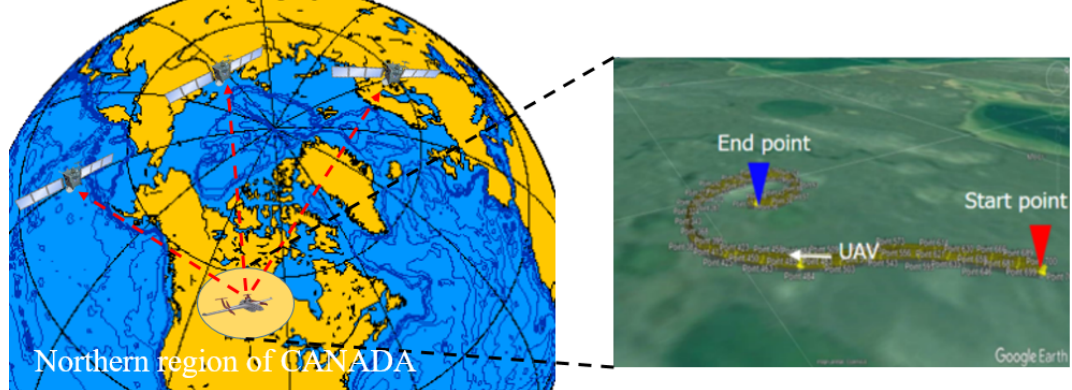
Figure 28. UAV target tracking in the northern region of Canada.